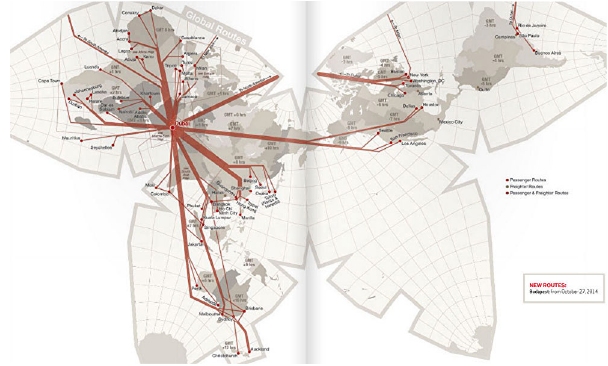
Fig. 16. Presentation of airline router from Dubai (source: D. Flynn 2014)